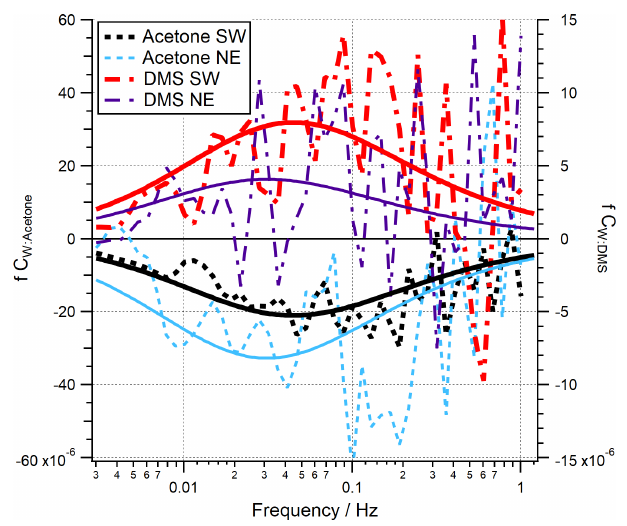
Figure 2. Mean flux co-spectra for acetone and DMS in the SW and NE wind sectors. Dashed/broken lines represent PPAO obser- vations. Solid lines represent the idealised spectral fits (Kaimal et al., 1972), where measurement height and wind speed are specified according to the measurement